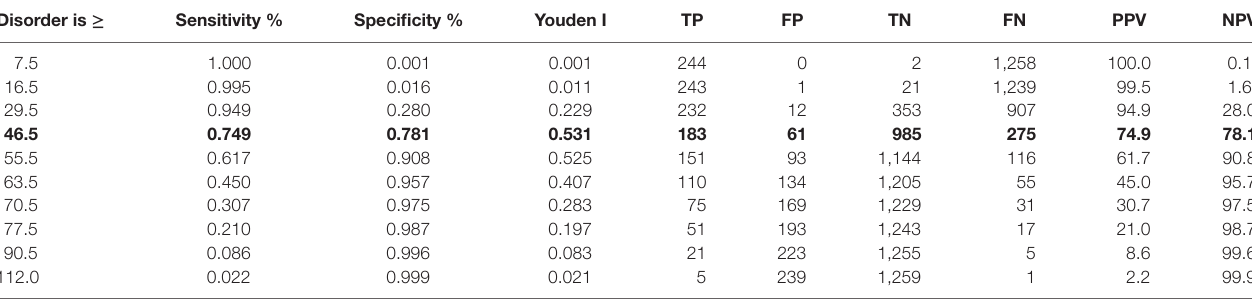
tAble 7 | Cut-off points of the assessment of sensory processing and executive functions in childhood questionnaire. disorder is